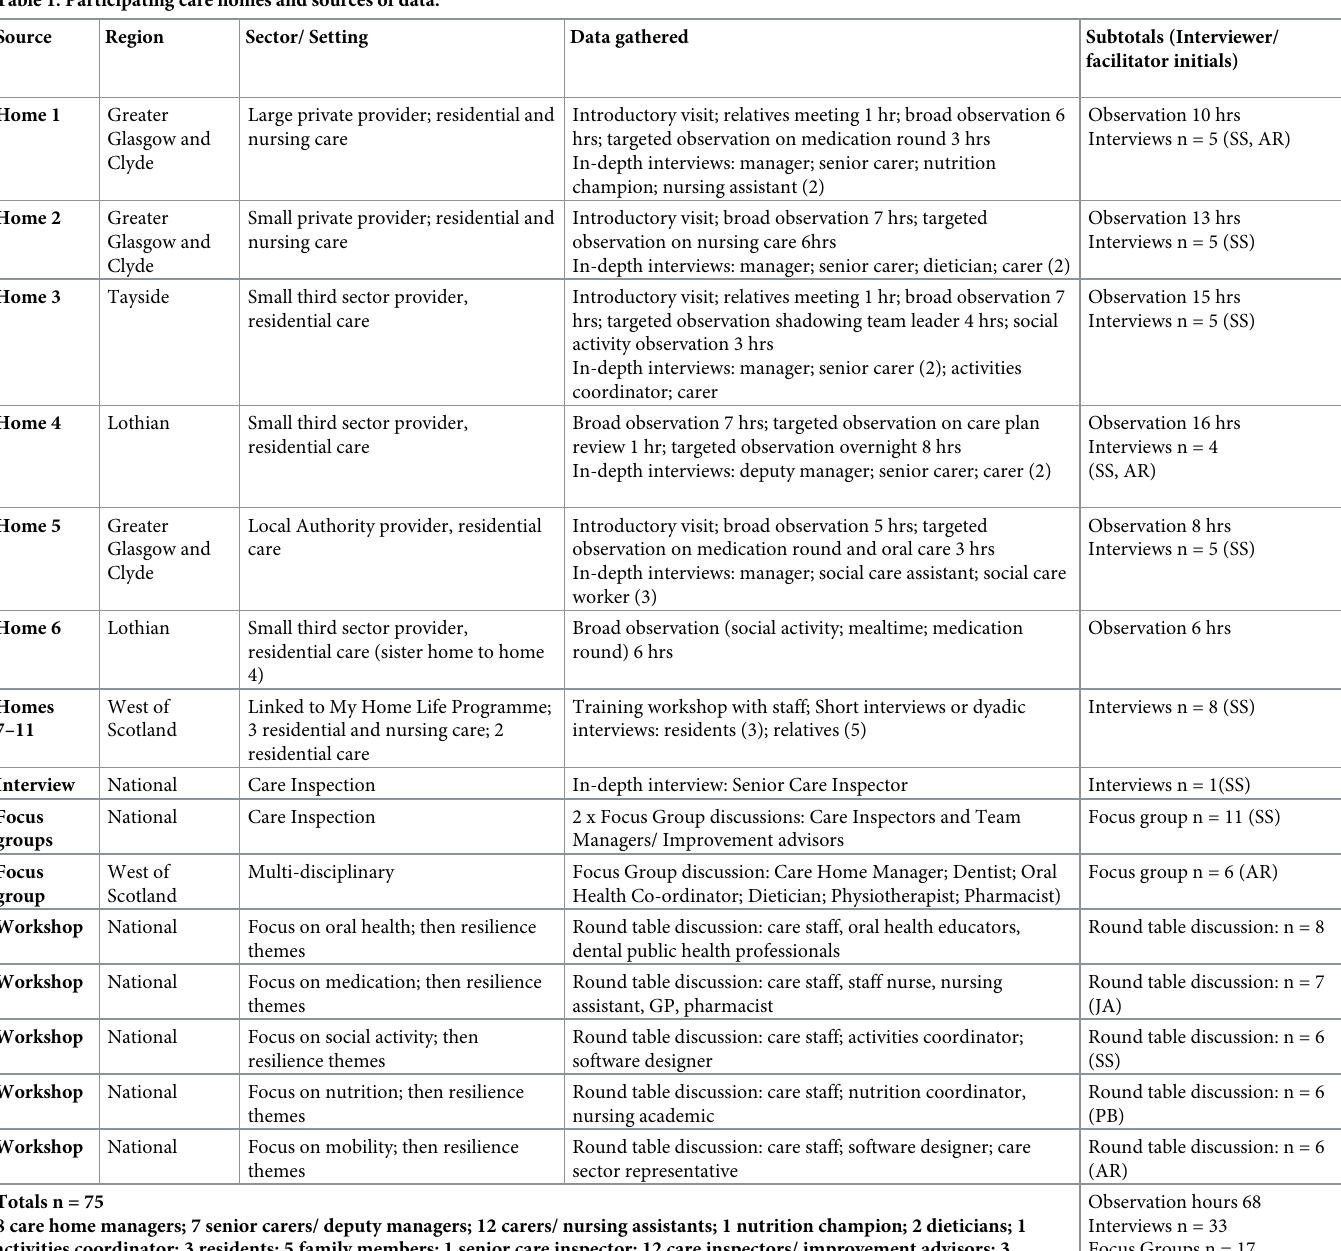
Table 1. Participating care homes and sources of data.